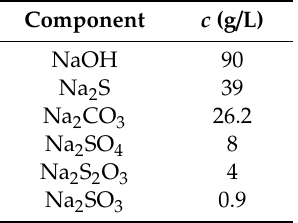
Table 7. Content of inorganic compounds in typical white liquor